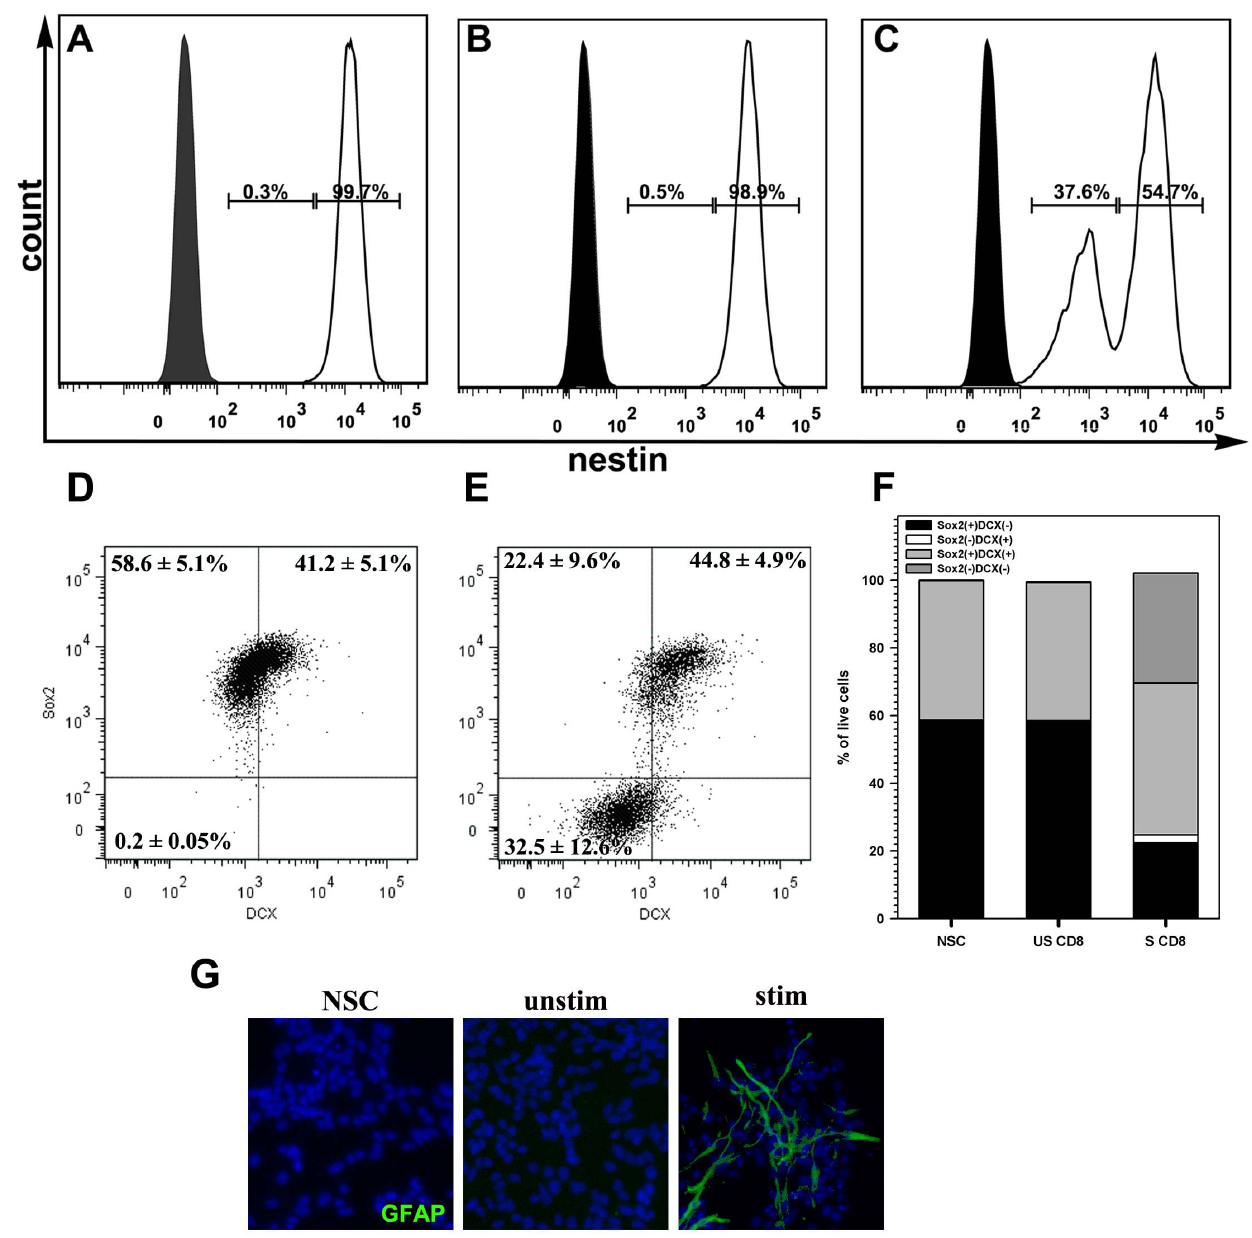
Figure 4. Activated CD8 lymphocytes initiate NSC differentiation. Co-cultures of NSC and lymphocytes were assessed for Nestin (a stem cell marker) expression by flowcytometry. NSCs were analyzed on a live cell gate after exclusion of CD45 + lymphocytes. (A) Histogram showing nestin immunoreactivity in untreated NSCs (open), compared to isotype antibody staining (shaded). Nestin expression in NSCs was measured 72 h after co- culture with (B) un-stimulated CD8 lymphocytes and (C) with activated CD8 lymphocytes. The amplitude of nestin expression and proportion of nestin-expressing cells decreased when NSC were co-cultured with activated CD8 + lymphocytes. Representative data from 2 separate experiments are presented. (D) Representative dot plots showing expression of Sox2 and doublecortin (DCX) on untreated NSCs or (E) NSCs cultured with antibody-stimulated CD8 T lymphocytes. (F) Stacked bars demonstrating changes in ratios of NSCs phenotypes, defined by Sox2 and doublecortin (DCX) expression, in untreated (NSC) cultures, NSCs cultured with unstimulated CD8 T-cell (US CD8), and NSCs cultured with antibody-stimulated CD8 T-cells (S CD8). (G) Immunohistochemistry of cultured NSCs showing differentiation into GFAP( + ) cells when treated with stimulated CD8 T cell (stim). Untreated (NSC) NSCs and those co-cultured with unstimulated CD8 T cells show no GFAP immunostaining (green fluorescence). Nuclei were counterstained with DAPI (blue).